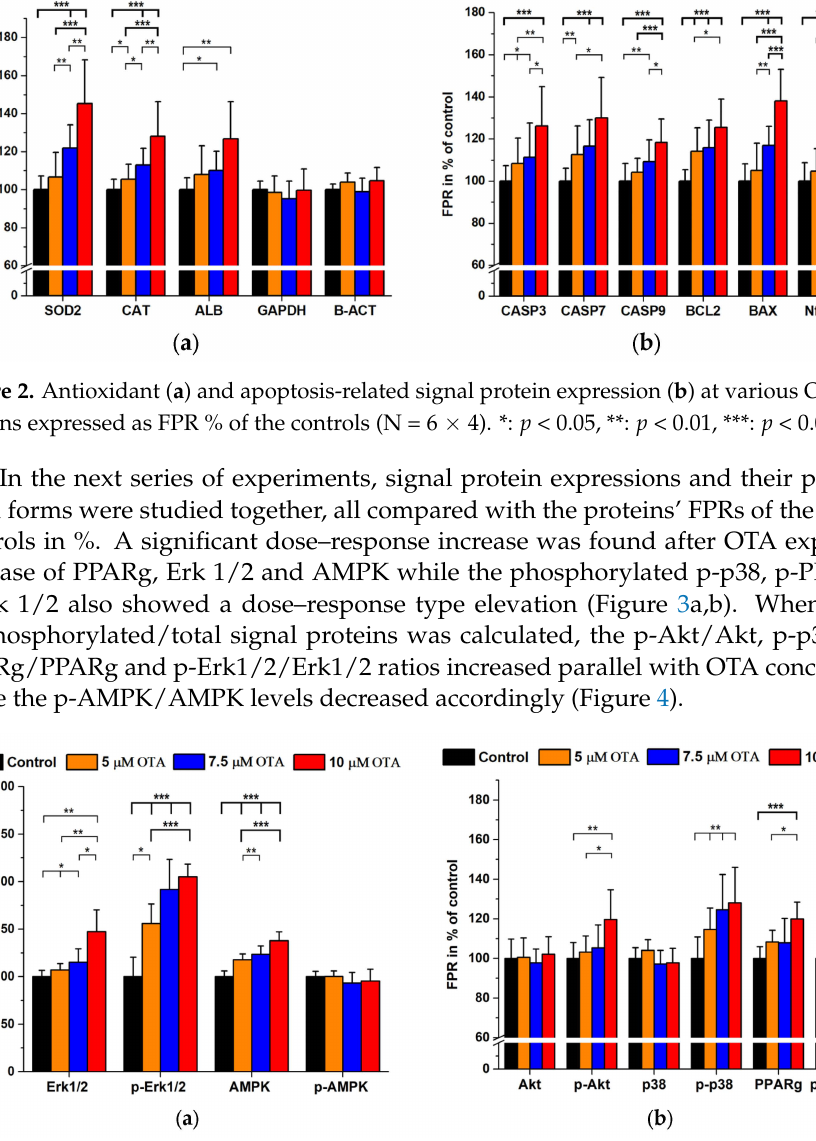
Figure 3. Signal protein and related phosphoprotein expression in OTA (0–10 µ M) treated HepG2 cells. (N = 6 × 4). ( a , b ): data expressed as FPR in % of the controls. *: p < 0.05, **: p < 0.01, ***: p <